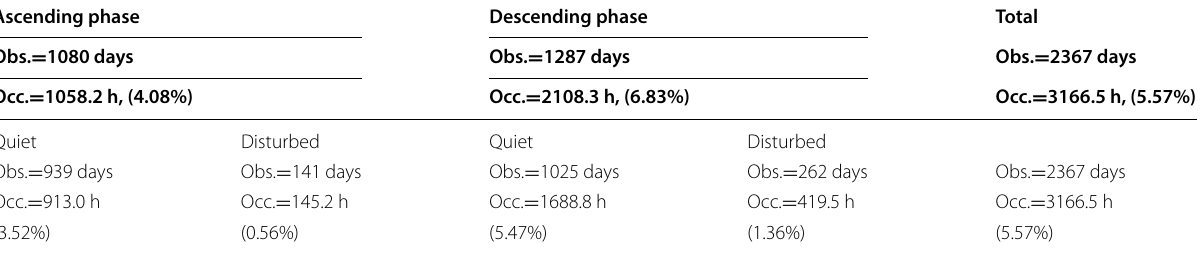
Table 1 Overall occurrence characteristics of EMIC waves in ascending and descending phases of solar cycle for